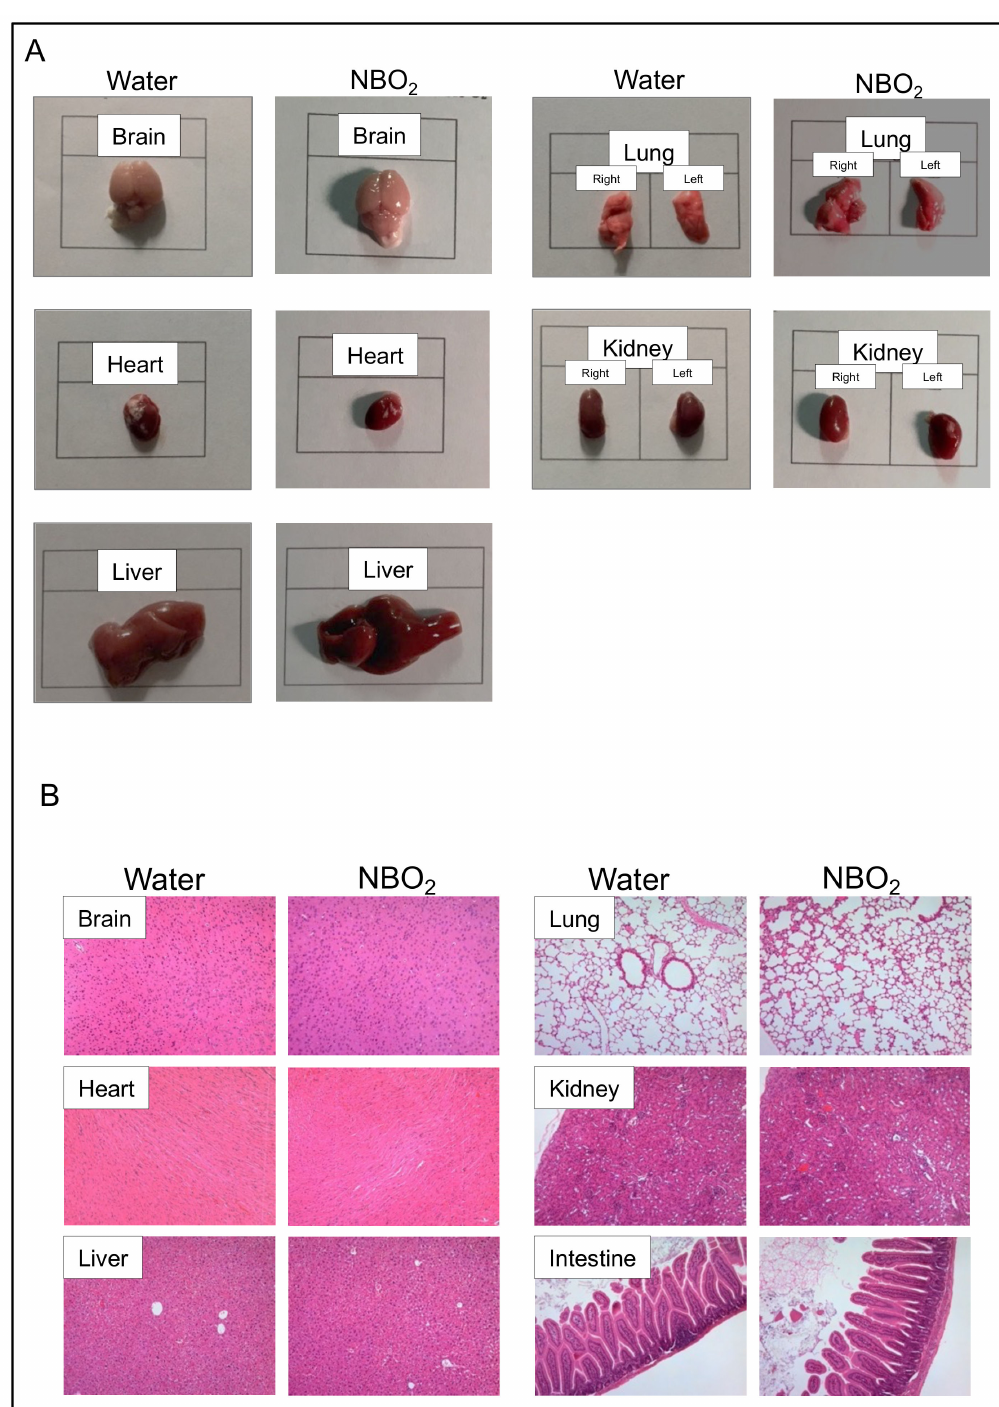
Figure 3. Macroscopic and histological findings of organs in healthy mice receiving free drinking water or NBO 2 water for 28 days. ( A ) Macroscopic view of organs in mice treated with water and NBO 2 water. ( B ) Histological findings of organs in mice treated with water and NBO 2 water (original magnification ×